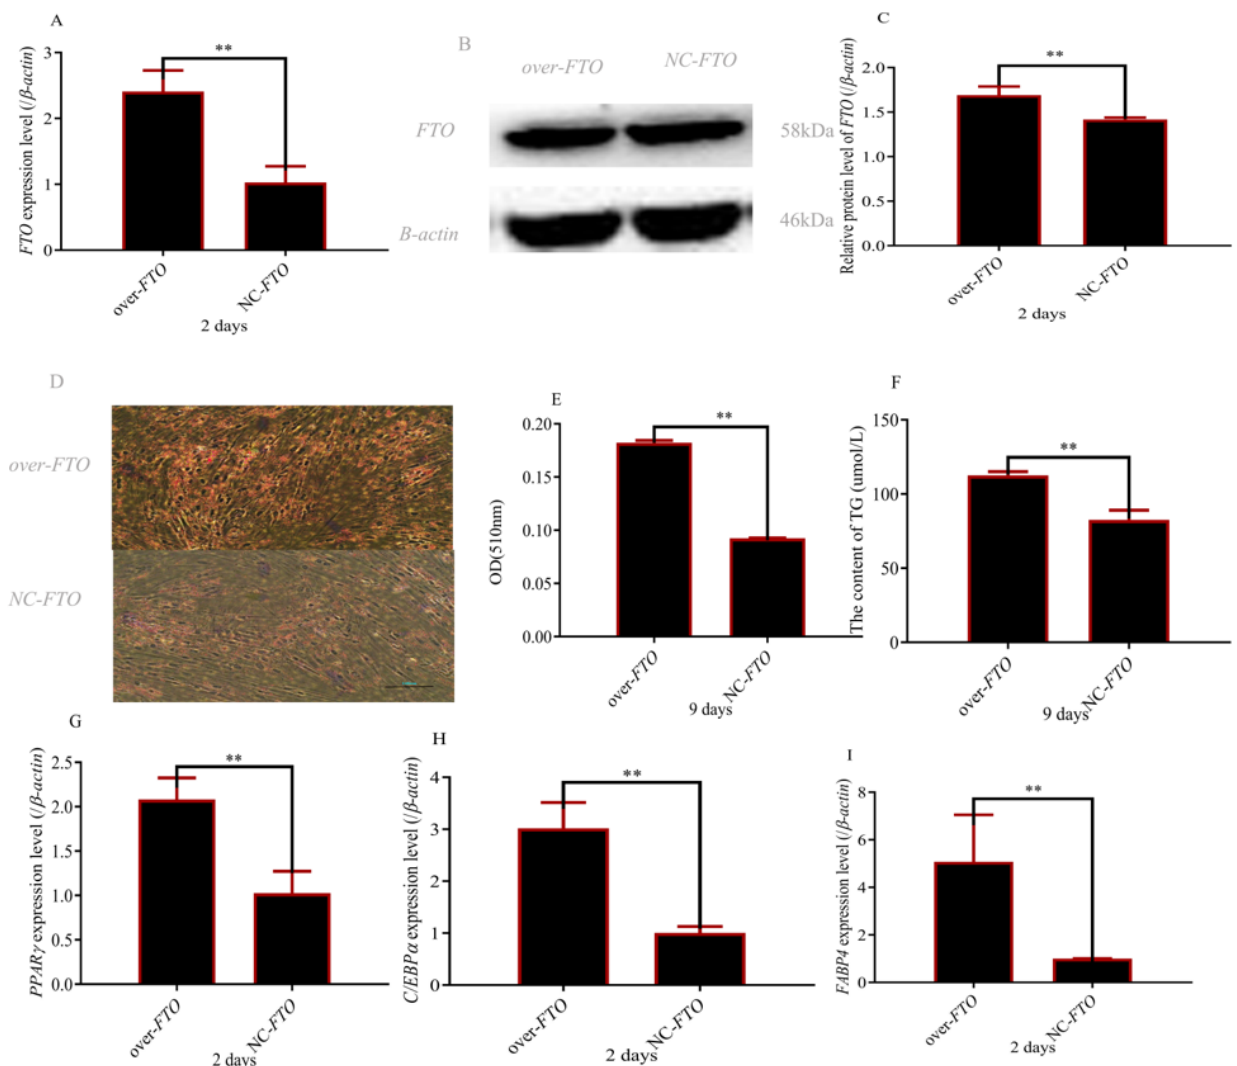
Figure 3. Overexpression of FTO gene promoted preadipocyte differentiation: ( A ) FTO expression level after overexpression of FTO ; ( B,C ) FTO protein level after overexpression of FTO ; ( D,E ) size and content of lipid droplets ( magnifications = 10 × 10); ( F ) Tri- level after overexpression of FTO ; ( B , C ) FTO protein level after overexpression of FTO ; ( D , E ) size and glyceride content; ( G – I ) expression levels of PPARγ , CEBPα and FABP4 after overexpression of FTO ( ** p ≤0.01 ). content of lipid droplets (magnifications = 10 × 10); ( F ) Triglyceride content; ( G – I ) expression levels of PPAR γ , CEBP α and FABP4 after overexpression of FTO ( ** p ≤